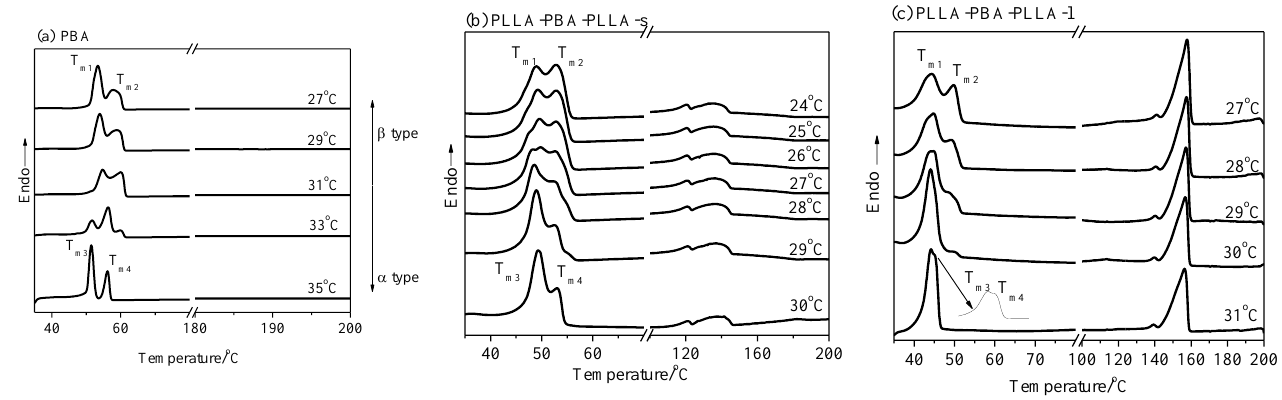
Figure 7. Melting curves of ( a ) PBA, ( b ) PLLA-PBA-PLLA-s, and ( c ) PLLA-PBA-PLLA-l after melt crystallization at a given temperature, and then heating directly from this given temperature at a heating rate of 10 °C/min under the thermal program 2.